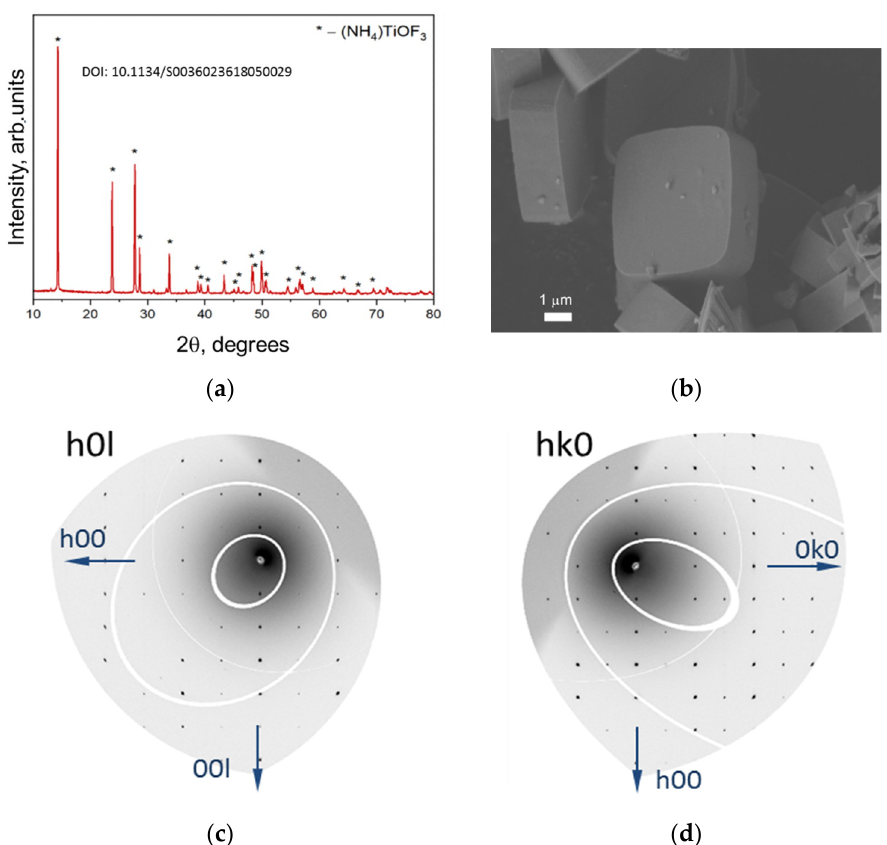
Figure 1. ( a ) Powder X-ray diffraction pattern of NH 4 TiOF 3 precursor. ( b ) SEM micrographs of NH 4 TiOF 3 mesocrystals formed in the presence of PEG-400. Scale bars are 1 µm. ( c ) and ( d ) images showing the HK0 and the H0L reciprocal space layers of an individual crystal of NH 4 TiOF 3 , respectively. Data were collected at the Swiss-Norwegian beamline BM01 at the European Synchrotron Radiation Facility (ESRF) in Grenoble, France.